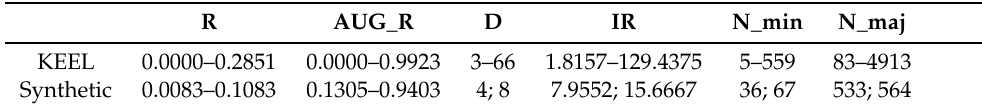
Table 1. The range of properties of the database